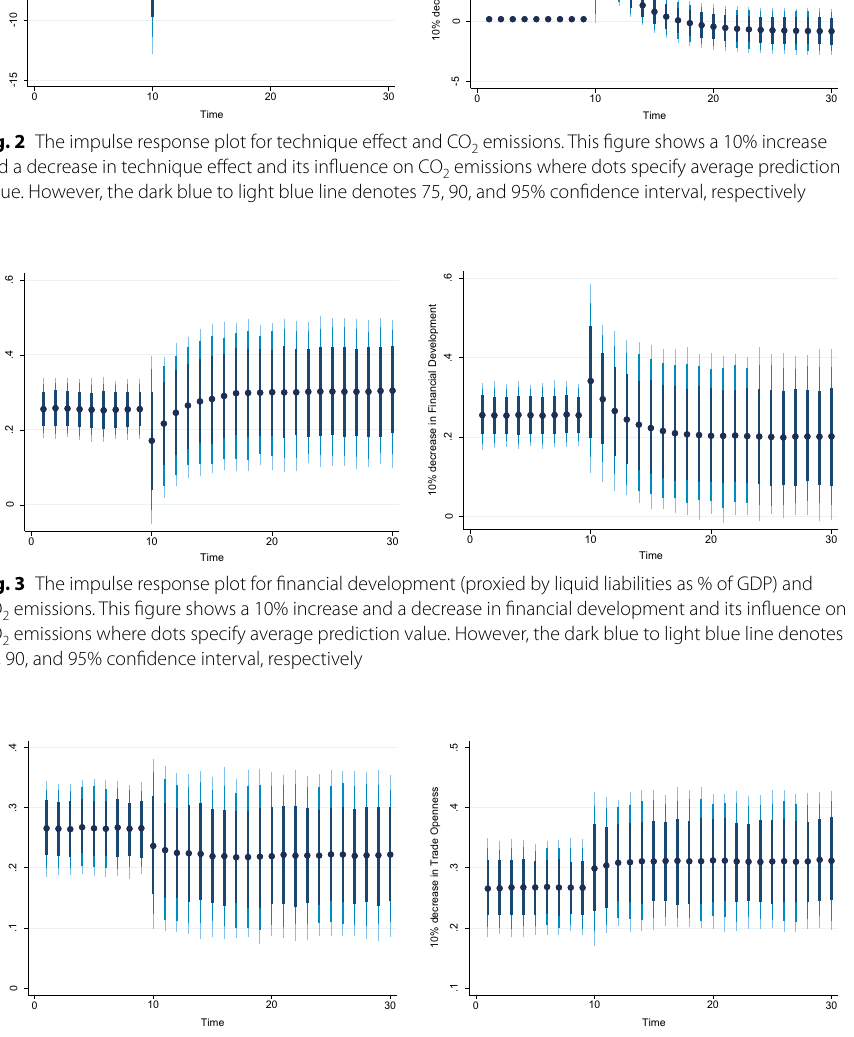
Fig. 4 The impulse response plot for trade openness and CO 2 emissions. This figure shows a 10% increase and a decrease in trade openness and its influence on CO 2 emissions where dots specify average prediction value. However, the dark blue to light blue line denotes 75, 90, and 95% confidence interval,